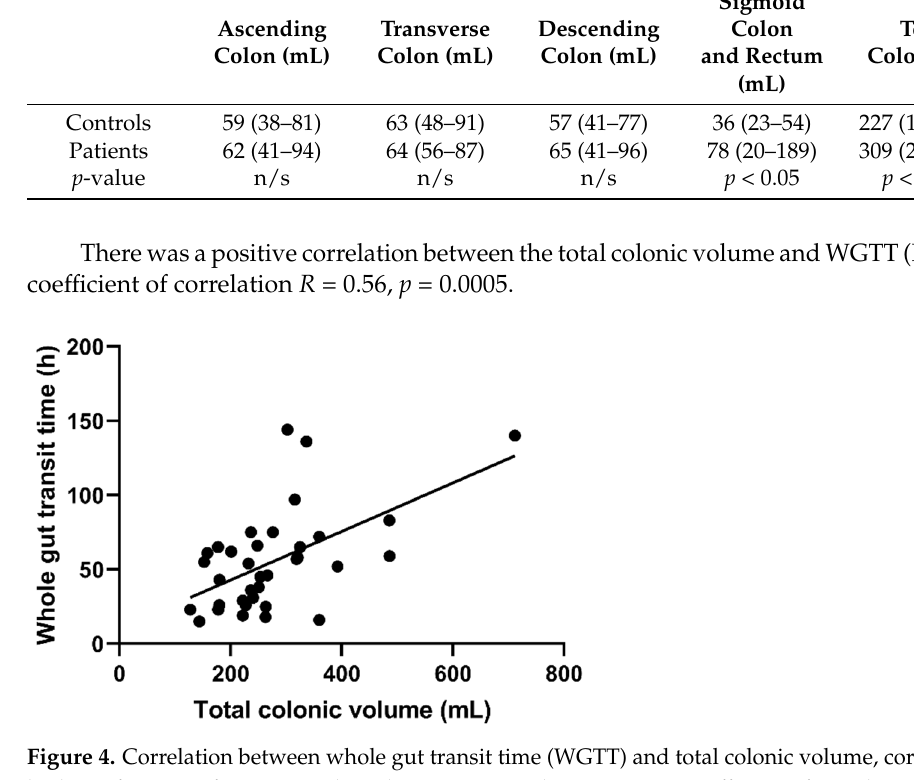
Table 1. Regional and total colon volumes corrected for body surface area for ascending colon, transverse colon, descending colon, and sigmoid colon and rectum for n = 16 patients with functional constipation and n = 19 controls. The data are presented in median (interquartile range). p -values versus control are indicated in the last line of the table; n/s = not significant.